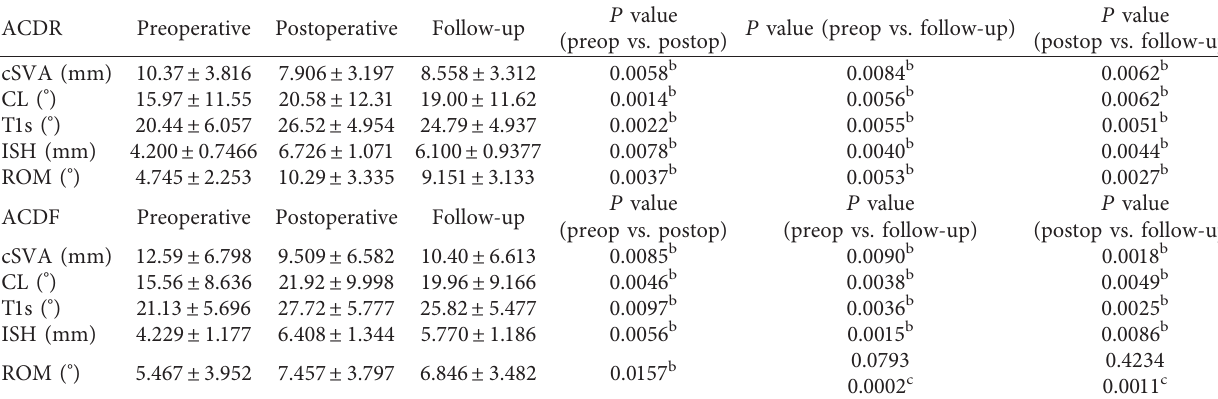
Table 4: Cervical sagittal alignment parameters a